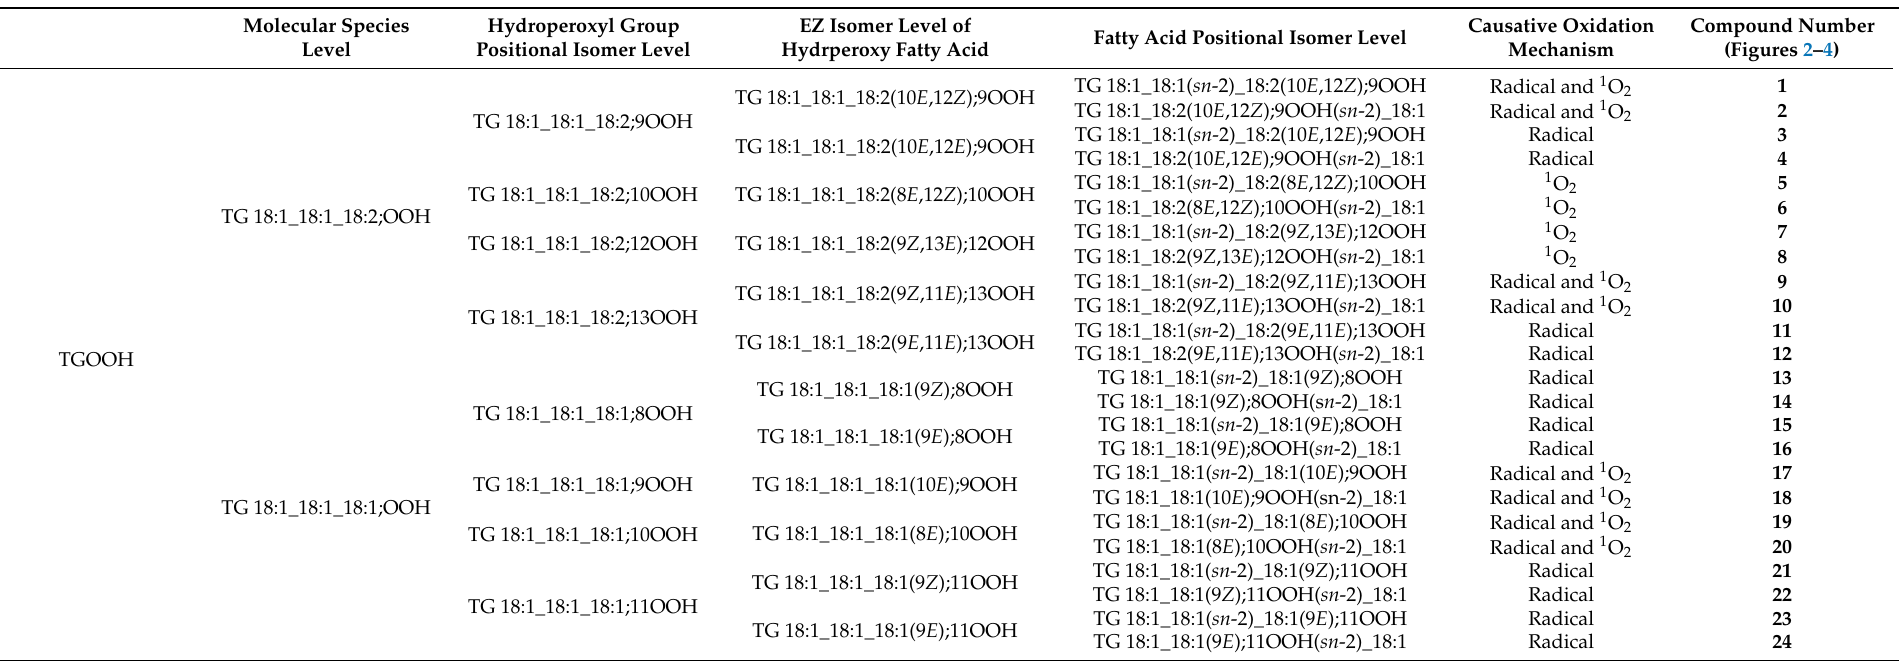
Table 1. The shorthand notation of lipids used in this study was in accordance with LIPID MAPS [30]. The shorthand represents lipid class, constituent fatty acid, geometrical structure, and functional group. For instance, TG 18:1_18:1( sn -2)_18:2(10 E ,12 Z );9OOH means a TGOOH composed of two oleic acids and a 9- hyderoperoxy-10 E ,12 Z -octadecadienoic acid. The binding position of an oleic acid is defined as sn -2 and that of other fatty acids is not defined. Unless otherwise noted, the structures are not defined (e.g., TG 18:1_18:1_18:2(10 E ,12 Z );9OOH implies both TG 18:1_18:1( sn -2)_18:2(10 E ,12 Z );9OOH and TG 18:1_18:2(10 E ,12 Z );9OOH( sn - 2)_18:1. Fatty acids used in this study were FA 18:1(9 Z ) and FA 18:2(9 Z ,12 Z ), and their double bond positions are not mentioned in this